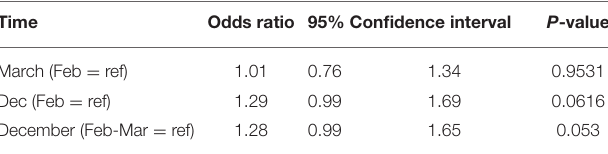
TABLE 4 | Univariate analyses of the effect of timing on physician prescribing of LT4 vs. any T3-containing therapy. Time